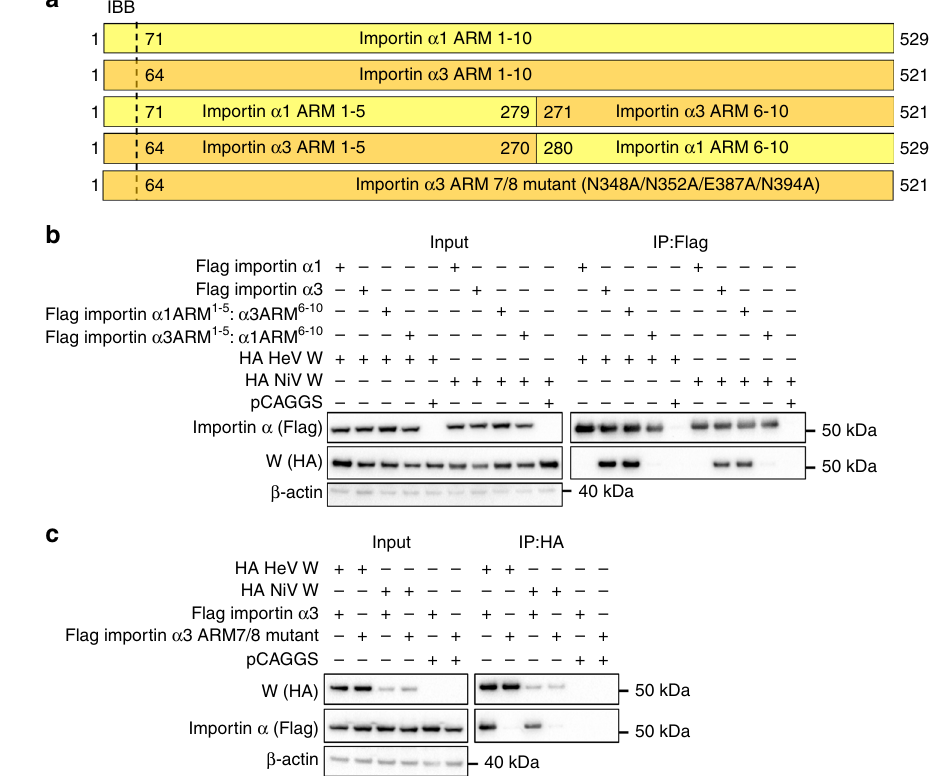
Fig. 7 Con fi rming the structural hypothesis through importin α chimeras. a Schematic representation of importin α 1, α 3, and chimeric importin α 1 ARM1-5 : α 3 ARM6-10 and importin α 3 ARM1-5 : α 1 ARM6-10 constructs. b Co-immunoprecipitation assay performed with Flag antibody on lysates of HEK293T cells expressing Flag-tagged importin α 1, α 3, importin α 1 ARM1-5 : α 3 ARM6-10 and importin α 3 ARM1-5 : α 1 ARM6-10 , and HA-tagged HeV W and NiV W, as indicated. Western blots were performed for HA and Flag. WCL, whole cell lysate; IP, immunoprecipitation. pCAGGS denotes empty vector control. c Co- immunoprecipitation assay performed with HA antibody on lysates of HEK293T cells expressing Flag-tagged importin α 1, α 3, importin α 1 ARM1-5 : α 3 ARM6-10 and importin α 3 ARM1-5 : α 1 ARM6-10 , and HA-tagged HeV W and NiV W, as indicated. Western blots were performed for HA and Flag. WCL, whole-cell lysate; IP, immunoprecipitation. pCAGGS denotes empty vector